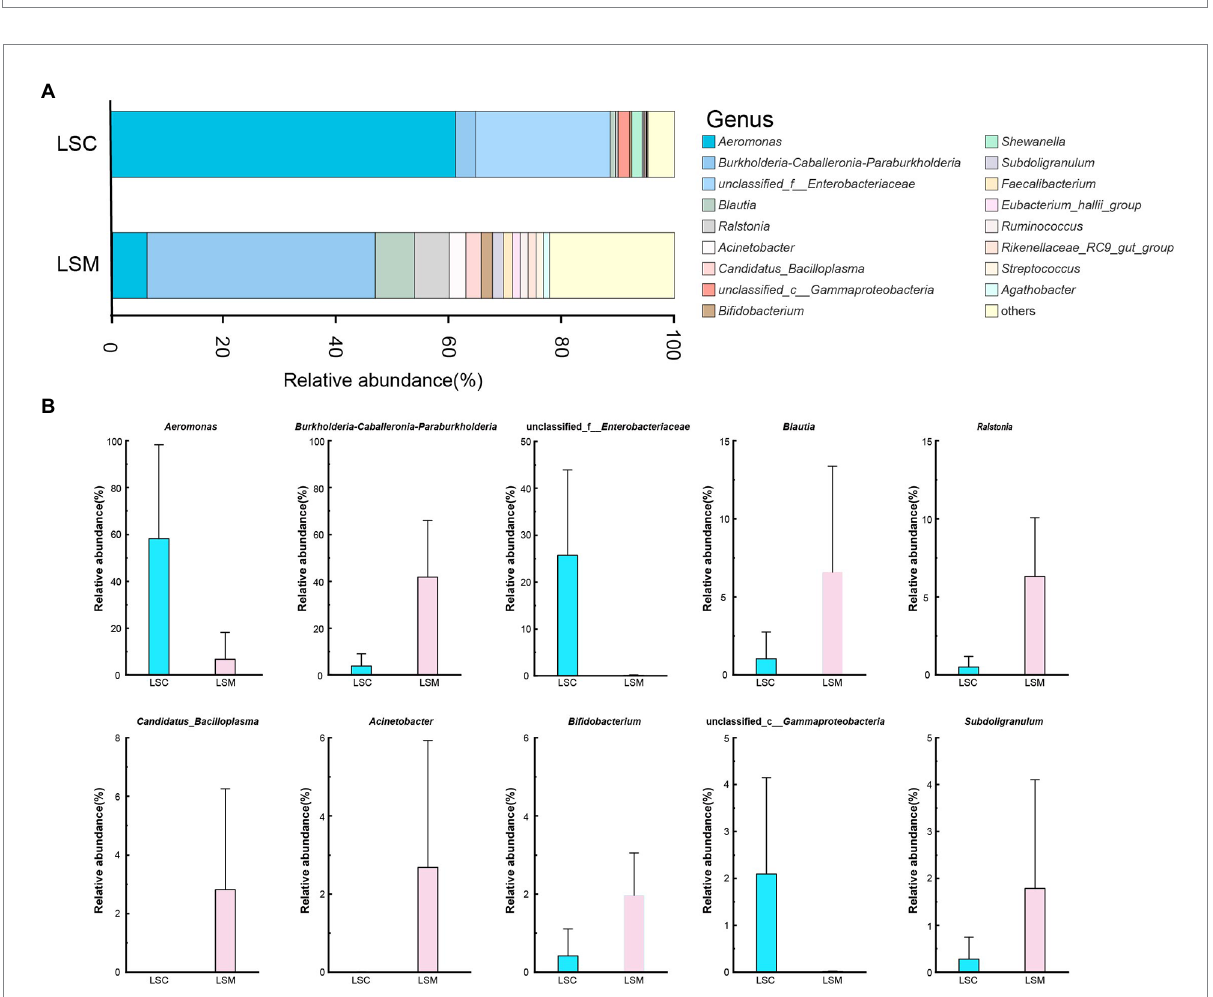
FIGURE 7 Composition of the genus of the gut microbiota in S. grahami . (A) Relative abundance of the first 17 genera. (B) Comparative differences at the genus level of the gut microbiota. * p <